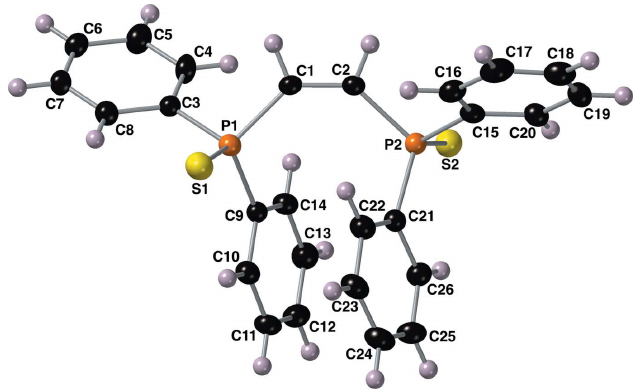
Figure 2 The molecular structure of compound I , with the atom-labeling scheme. Displacement ellipsoids are drawn at the 40% probability level using standard CPK colors.